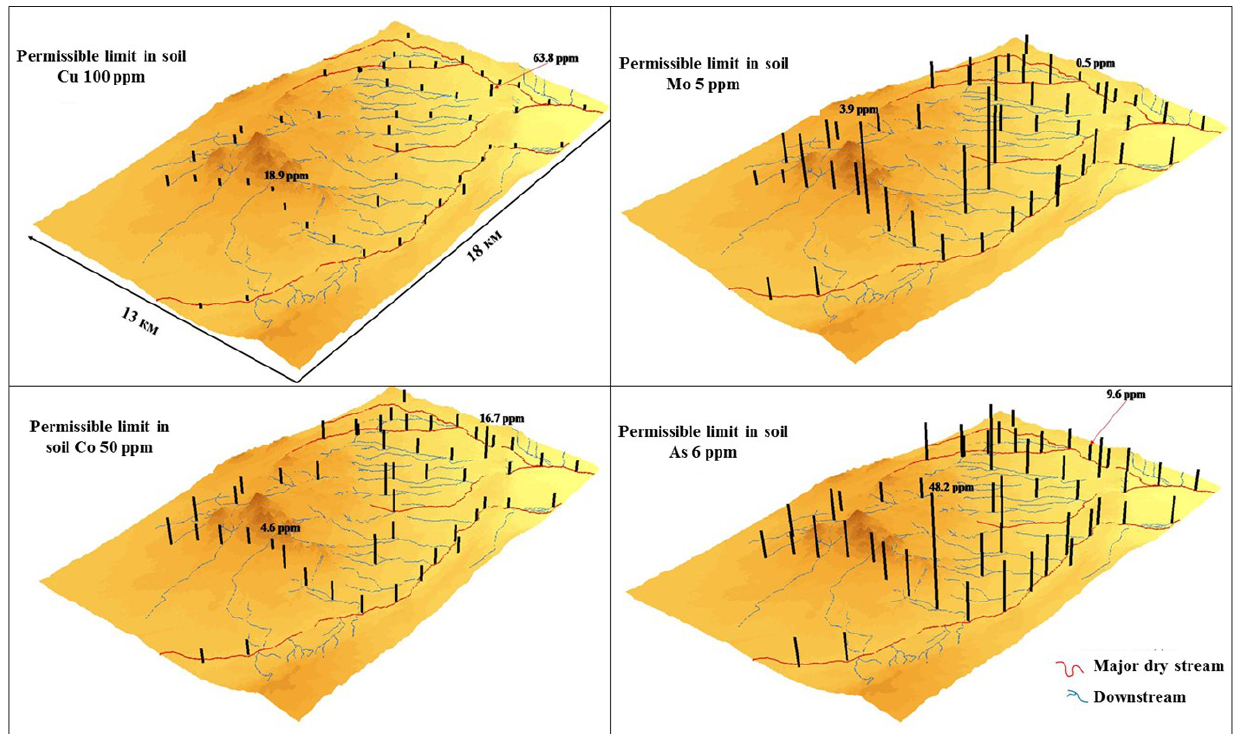
Fig. 5. Distribution of selected heavy elements in the soil of the Shuteen area by 3D images (Batkhishig et al.,